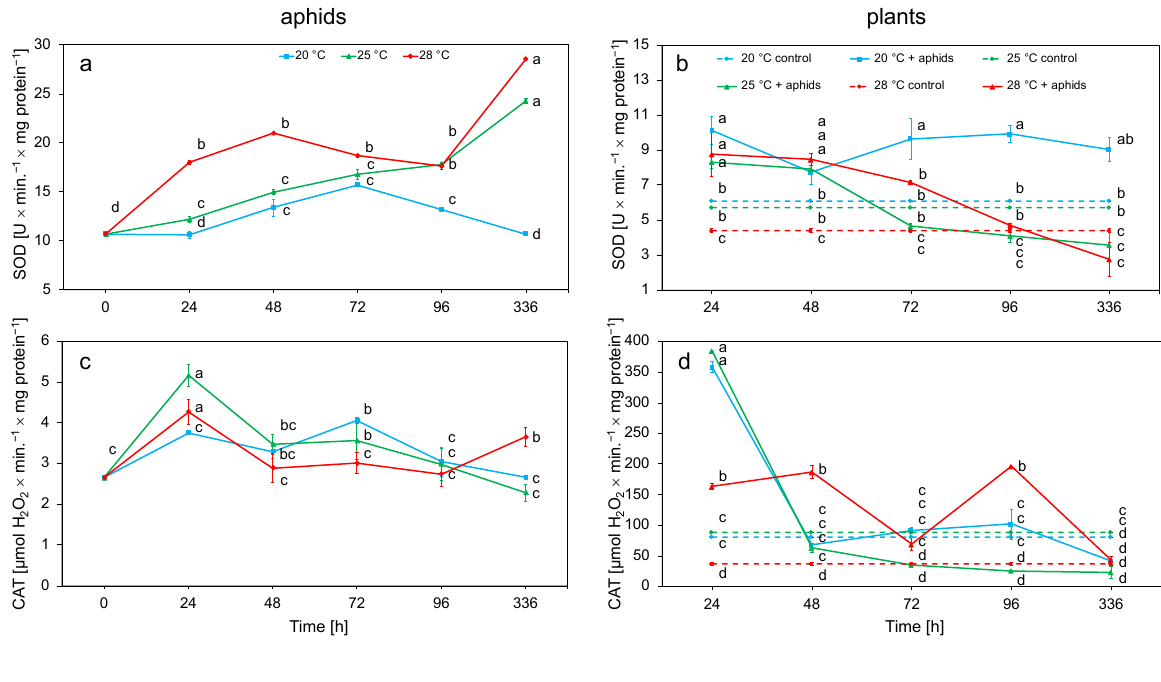
Figure 3. Changes in the SOD and CAT activity (means ± SE) in the tissues of aphid Macrosiphum rosae ( a , c ) and plant Rosa rugosa at different temperatures and during aphid feeding ( b , d ). Values marked with different letters differ significantly at p < 0.05 (Duncan